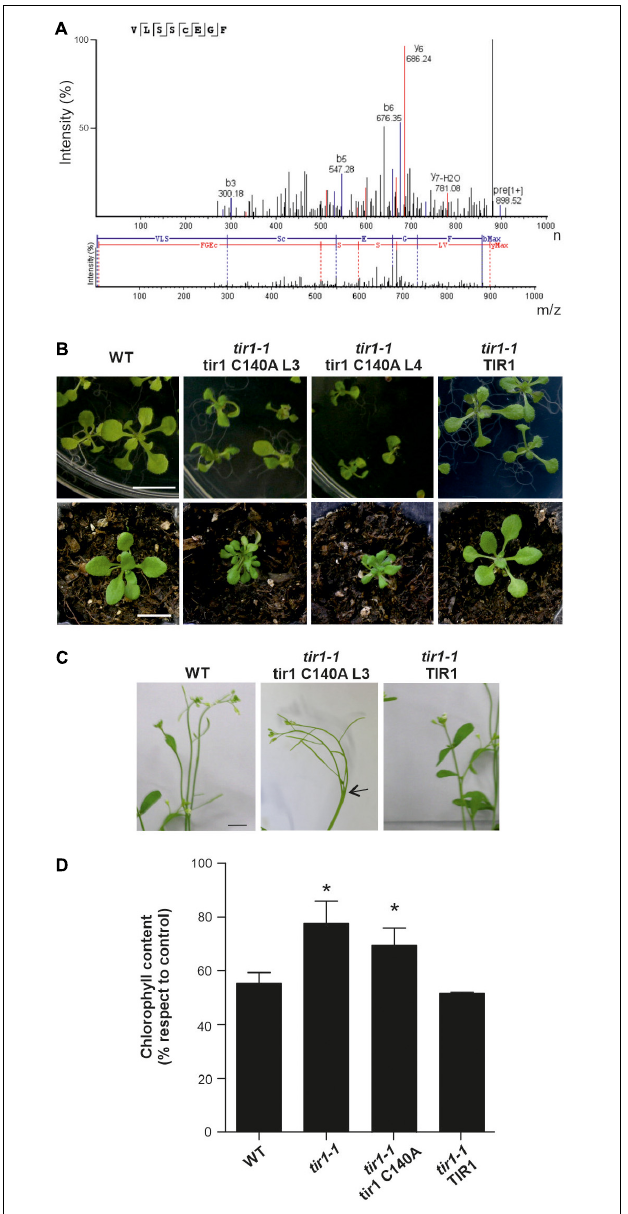
FIGURE 1 | TIR1 S-nitrosation of Cys140 residue. (A) MS/MS spectrum showing fragmentation patterns that correspond with ions of the y (blue) and the b (red) series of S-carbamidomethylated Cys140 peptide after treatment of TIR1 with GSNO and ascorbate switch, which specifically substitutes S-nitrosated Cys to carbamidomethylation. (B) Phenotype of different tir1-1 35S:tir1 C140A transgenic lines overexpressing non-nitrosable TIR1 protein. Representative pictures of WT, tir1-1 35S:TIR1 and tir1-1 35S:tir1 C140A (L3 and L4) seedlings grown during 15 days on horizontally oriented Arabidopsis thaliana salts (ATS) agar plates (upper panels) and in soil during 21 days (lower panels) are shown. Scale bar: 1 cm. (C) A representative picture of morphological defects in inflorescences is shown. Arrow indicates fused bolts. Scale bar: 5 mm. (D) Ten-day-old seedlings were transferred to liquid ATS medium supplemented with 200 mM NaCl for 3 d. Chlorophyll content was measured spectrophotometrically and relativized to untreated seedlings (control). Data are mean values ( ± SE) of three independent experiments. * P < 0.05 ( t -test against WT).